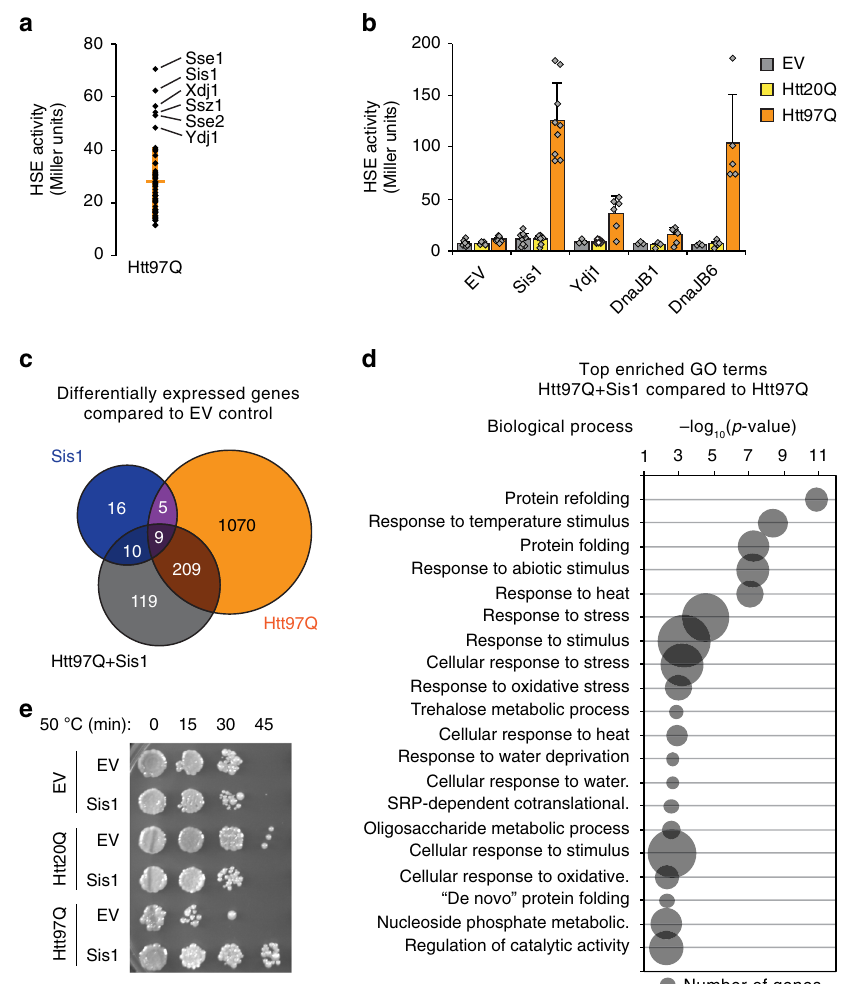
Fig. 2 Sis1 enables stress response activation by polyQ expansion protein. a Screen for factors allowing induction of the HSR by Htt97Q. β -Gal activity is shown for P HSE LacZ containing cells expressing Htt97Q and overexpressing one of 50 yeast chaperones. Orange line represents screen average, orange bars represent SD. Signi fi cant hits falling outside the SD are identi fi ed. See also Supplementary Table 1. b Sis1 overexpression enables stress response activation. β -Gal activities were measured in P HSE LacZ reporter cells expressing empty vector (EV), Htt20Q or Htt97Q (P GAL ) and overexpressing the Hsp40 chaperone proteins indicated under the GPD promoter. Data represent mean + SD from at least three independent experiments. c Transcriptional response to Htt97Q. The numbers of genes differentially expressed compared to control cells are represented in a Venn diagram after transcriptome analysis of control cells, cells overexpressing Sis1, and cells expressing Htt97Q with and without overexpression of Sis1. EV empty vector. Experiments were performed in triplicate. See also Supplementary Table 2. d Genes upregulated with Sis1 overexpression in Htt97Q containing cells correspond to HSR associated pathways. The top enriched GO biological processes ( p < 0.005) for differentially expressed genes upregulated in Htt97Q cells upon Sis1 overexpression. p values were calculated using the GOseq R package, which corrects for gene length bias. See also Supplementary Table 3. e Sis1 mediated HSR induction by Htt97Q has protective effects. Cells were grown at 30 °C after expression of Htt20Q, Htt97Q, or EV control with or without Sis1 overexpression and exposure to heat shock at 50 °C for the indicated times. The experiment was performed in triplicate; a representative result is